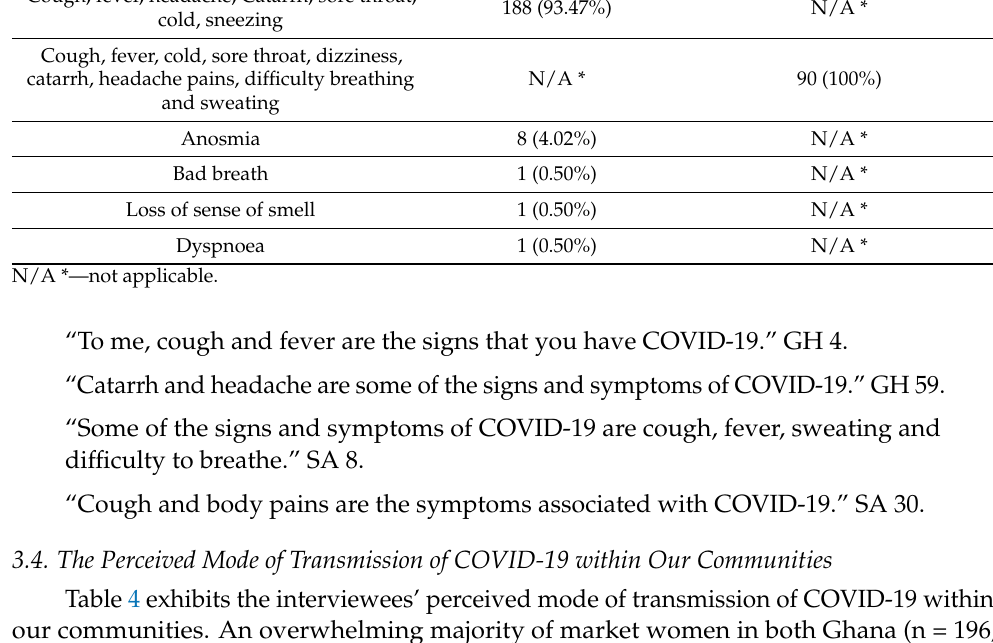
Table 3. Perceived signs and symptoms of COVID-19. Variable Ghana ( N = 199) No. (%) South Africa ( N = 90) No. (%) Perceived signs and symptoms of